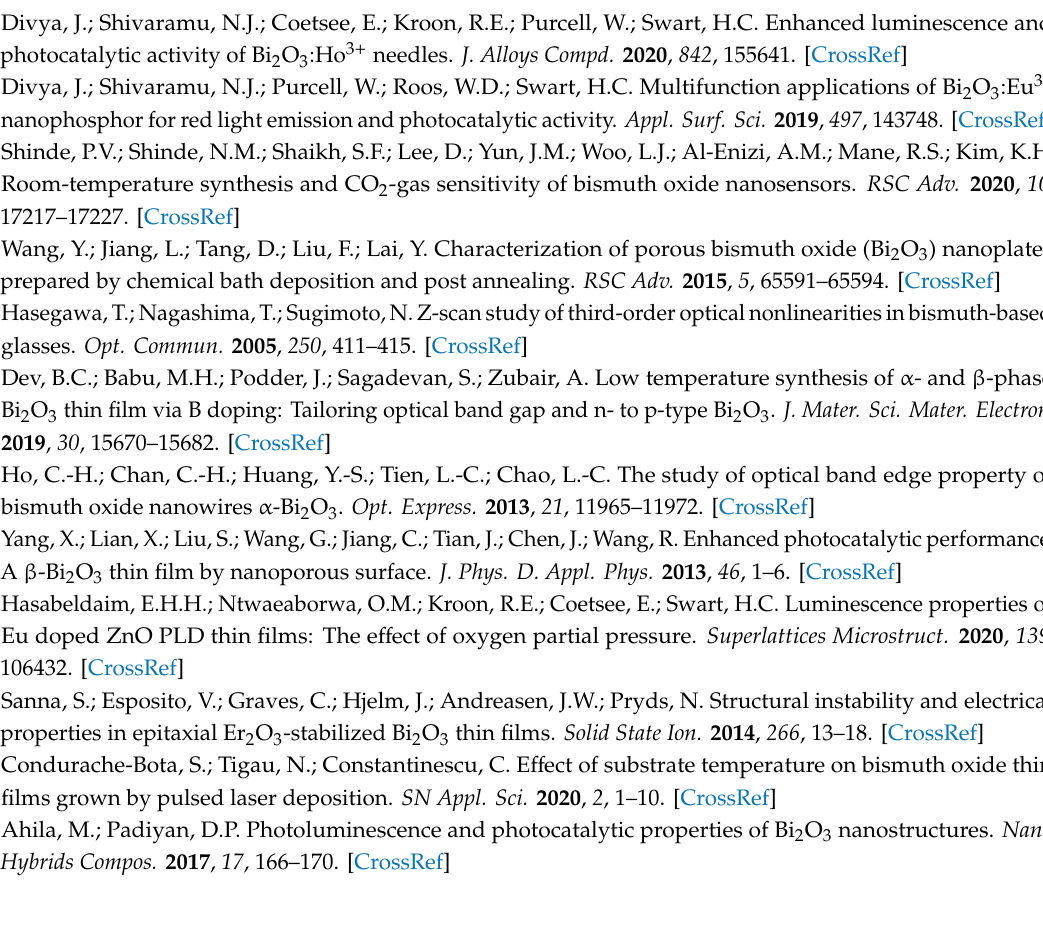
Figure S1: EDS of Bi2O3:Ho 3 + (1 mol.%) deposited at di ff erent substrate temperatures (RT–600 ◦ C) in vacuum, Figure S2: FESEM image (a) EDS taken at spot 1 (b) and spot 2 (c) of Bi 2 O 3 :Ho 3 + (1 mol.%) deposited at T S = 600 ◦ C, Figure S3: FESEM images of the sample deposited with O 2 partial pressure of 200 mT (T S = 400 ◦ C) with di ff erent magnifications as indicated by the scale bars in (a) and (b) of the Bi 2 O 3 :Ho 3 + thin film, Figure S4: EDS of Bi2O3:Ho3 + (1 mol.%) deposited at di ff erent O 2 partial pressure (5–200 mT) with T S = 400 ◦